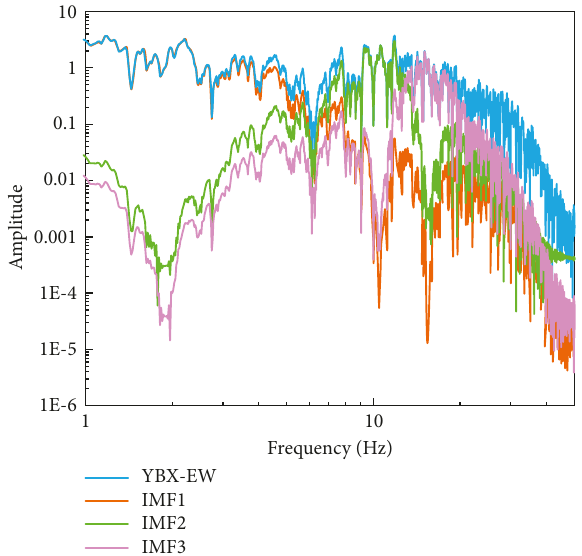
Figure 9: Fourier spectrums of the 53YBX-EW and its